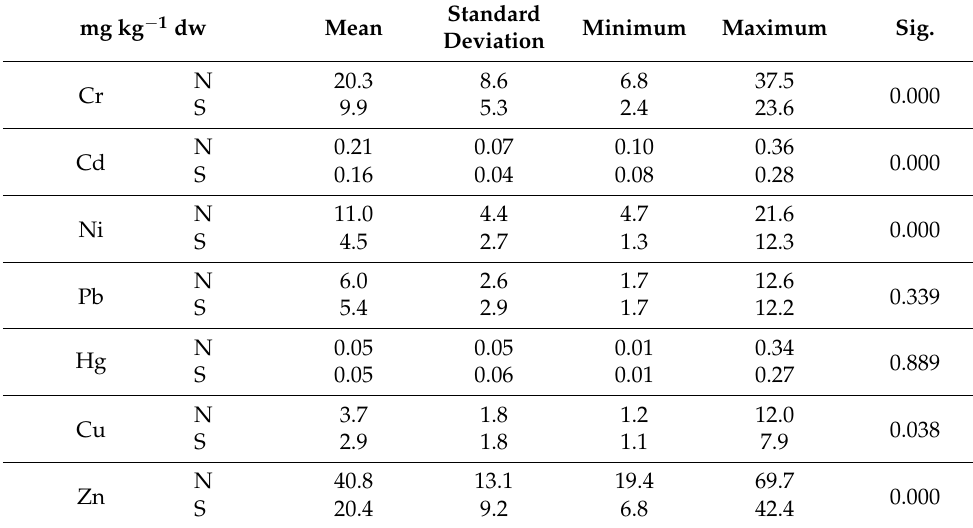
Table 3. Statistical parameters for the measured metals in the sediments of northern and southern water bodies of the VC (N: north; S: